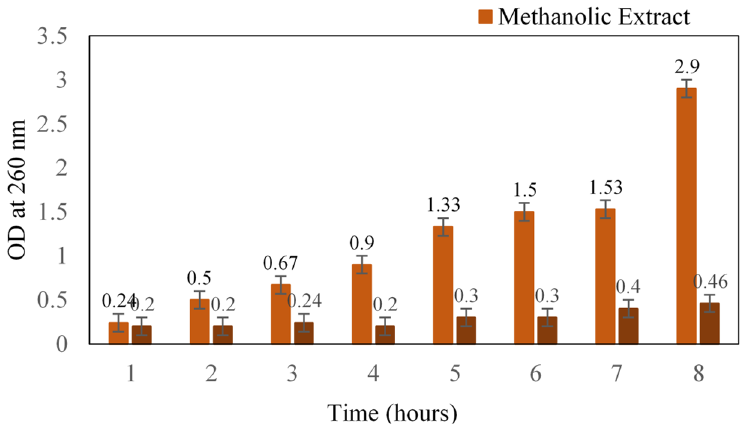
Figure 1. Loss of cellular content upon treatment with methanol extract of Simarouba glauca against S. aureus. Absorbance was read at 260